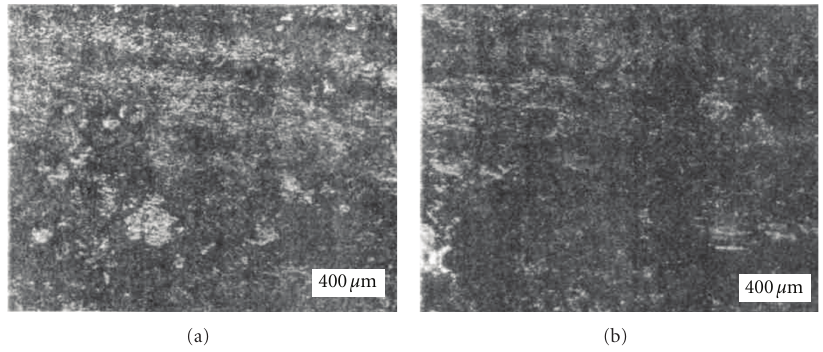
Figure 8: Friction surface of porous iron OSCh 6-2 specimen, × 50: (a) 2% porosity, (b) 20%